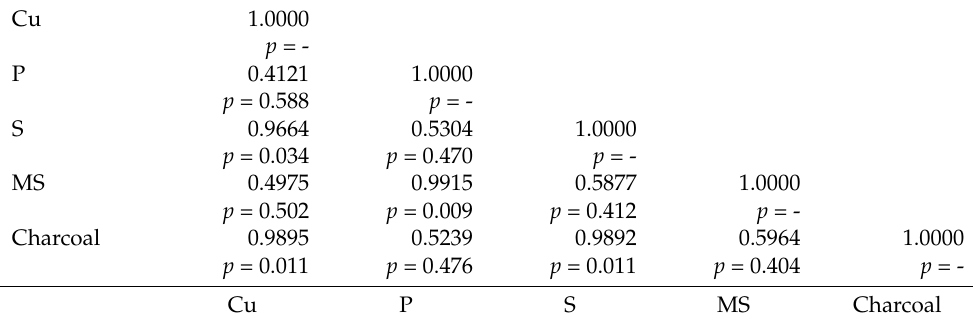
Table 4. Correlation matrix of chosen (Cu, P, S, MS, and microcharcoal) elements. Marked correlations are significant at p < 0.05000, n =